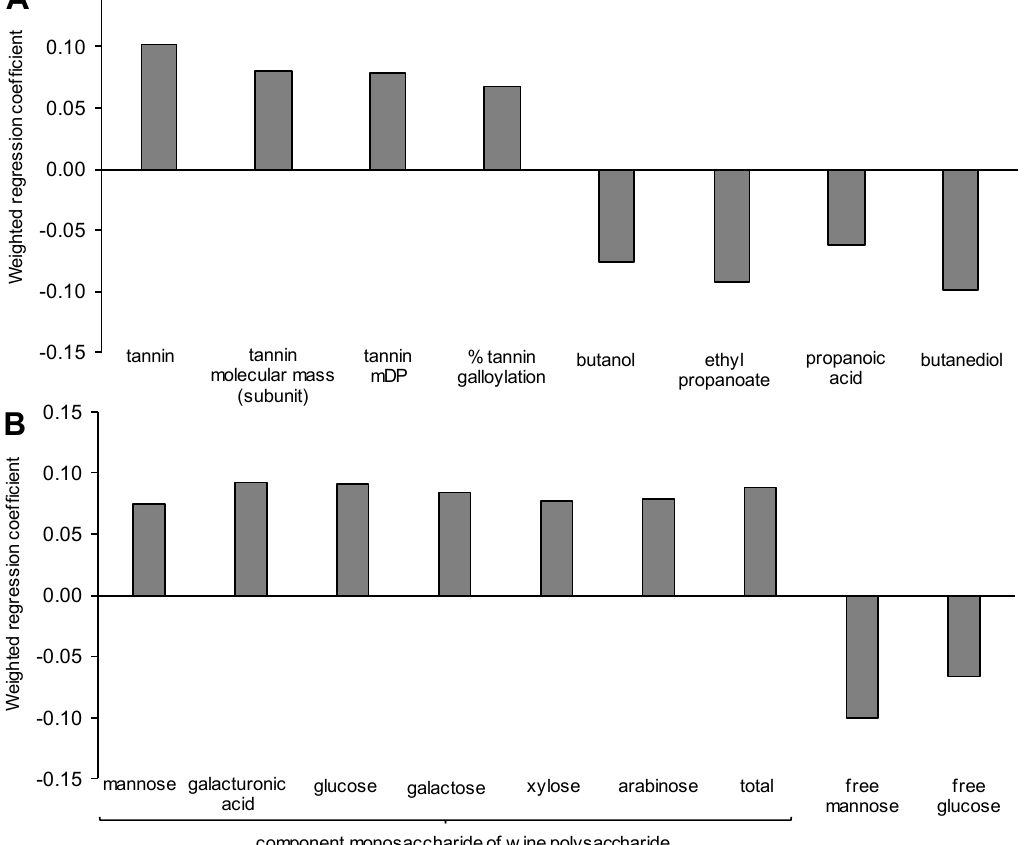
Figure 4. Weighted regression coefficients determined from partial least squares regression (PLS1) analysis of significant wine compositional variables to predict the sensory attribute astringency showing ( A ) tannin composition and fermentation products; ( B ) free and polysaccharide ‐ associated monosaccharides.